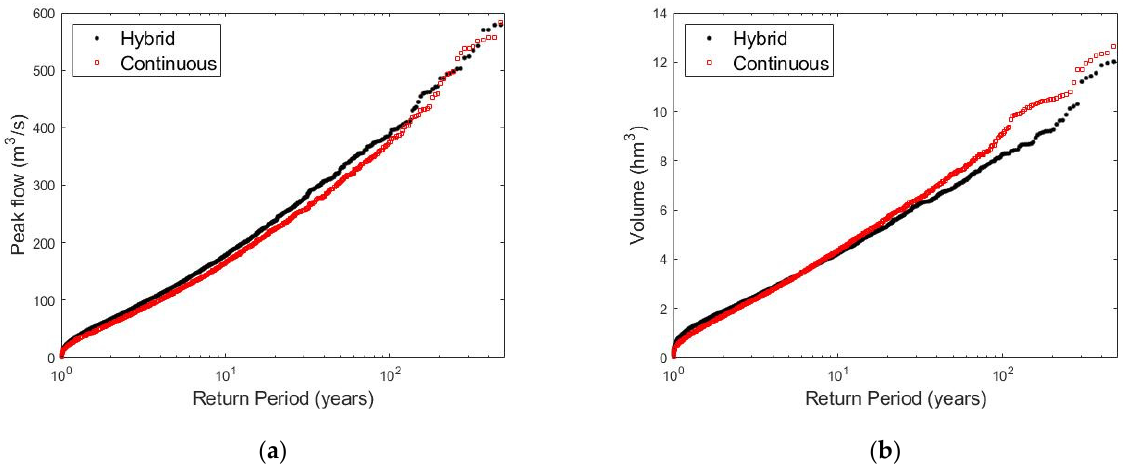
Figure 8. Univariate flood frequency distributions of maximum annual peak-flows ( a ) and volumes ( b ). Black dots represent the results obtained by the hybrid-based method, whereas red dots represent the values obtained from the continuous simulation.